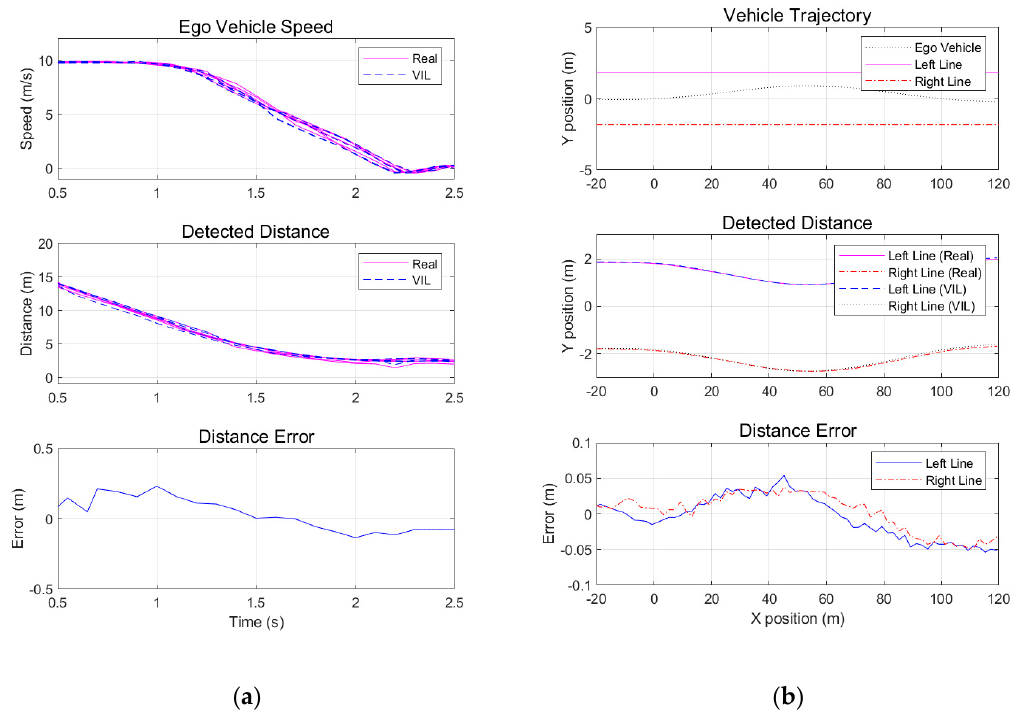
Figure 6. Testing result of ( a ) AEB with a radar sensor; ( b ) LKAS with a vision sensor.